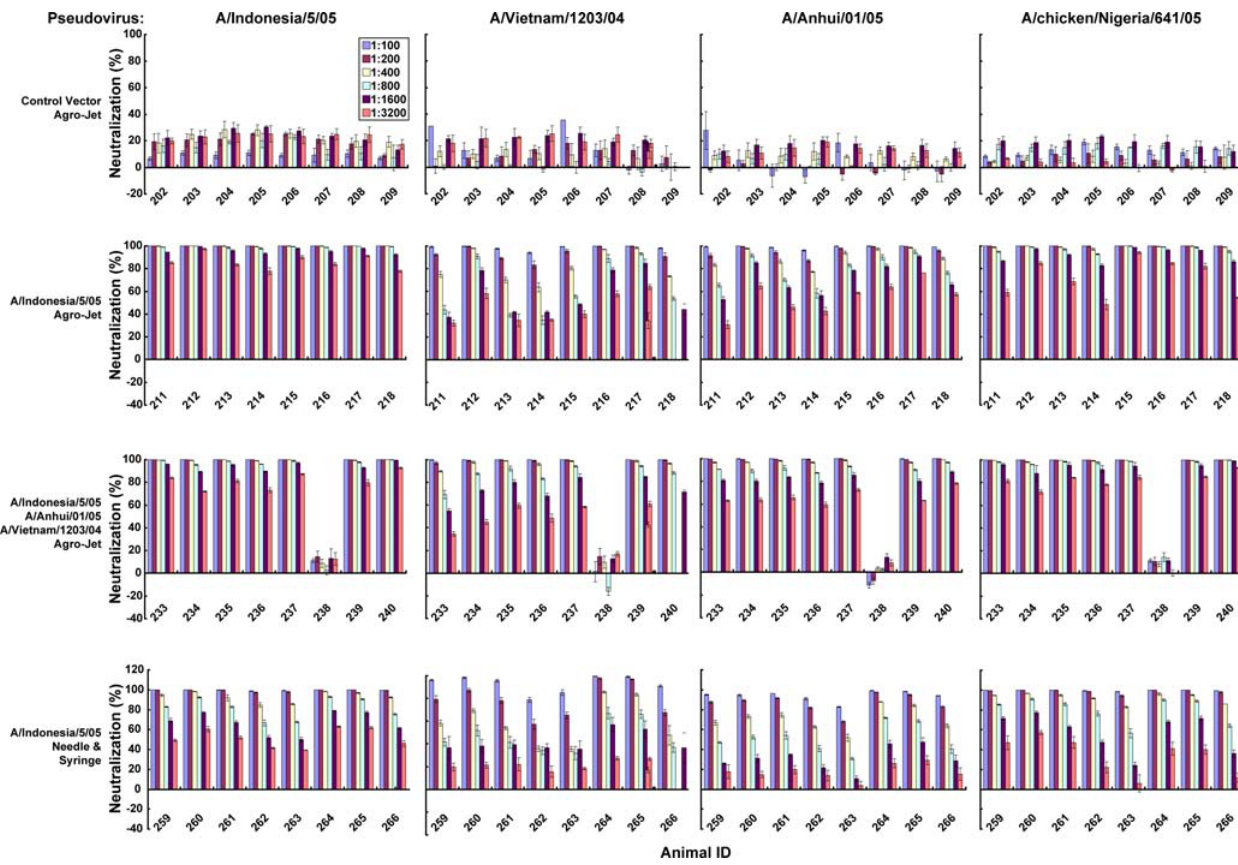
Figure 4. Neutralizing antibody responses against homologous and heterologous HAs from chickens immunized with HA expression vectors by different routes. Neutralization against the indicated strain HAs was analyzed after immunization with trivalent HA encoding plasmids: pCMV/R-HA(A/Indonesia/05/2005), pCMV/R-HA(A/Anhui/1/2005), and pCMV/R-HA(A/Vietnam/1203/2004) with the indicated delivery device using sera taken two weeks after the third injection. Neutralization was determined by LAI from individual chickens at titers ranging from 1:100 to 1:3200. Bird # 238 consistently showed a low level of neutralization, possibly because of an inhibitor in the serum because it was fully protected against viral challenge. Percent neutralization was calculated by the reduction of luciferase activity relative to the values achieved in the non-immune sera.